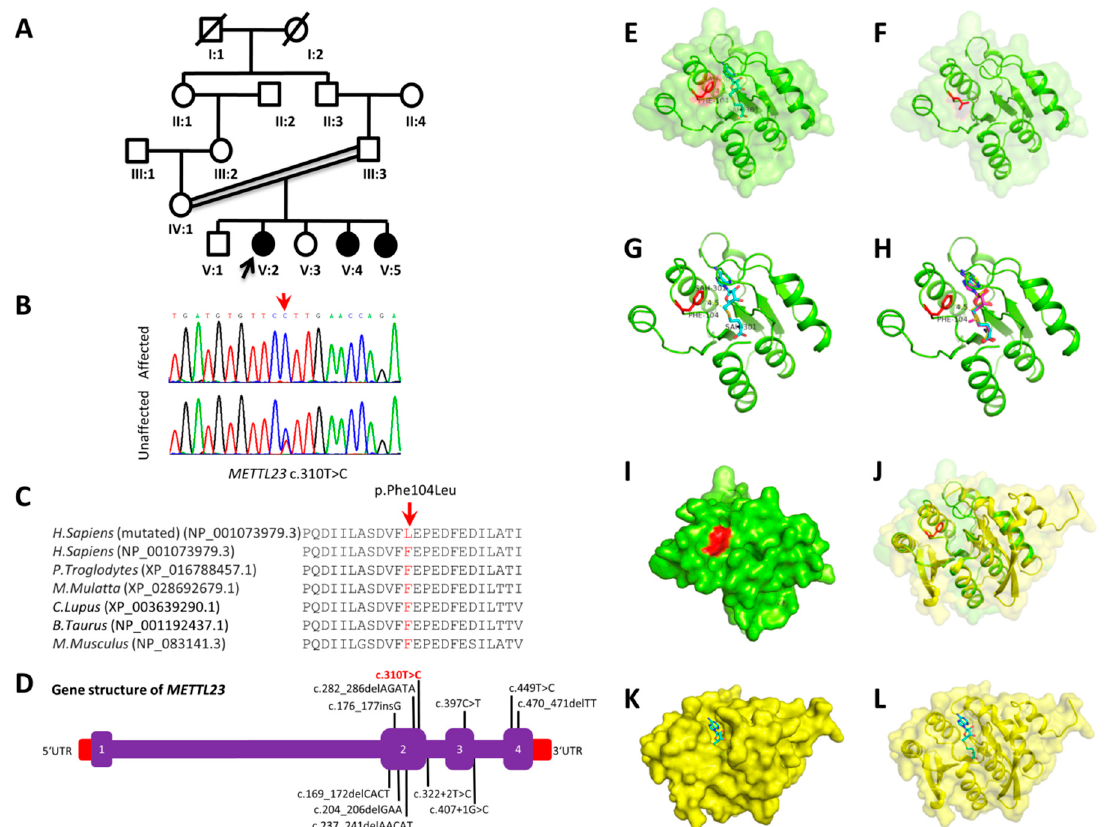
Figure 1. ( A ) Pedigree of family B, exhibiting autosomal recessive inheritance. ( B ) Sanger sequencing results of family (B). The red arrow indicates the localization of the variant. ( C ) Conservation of Phe104 across different species. ( D ) Gene structure of METTL23 . Known variants are indicated on the gene structure. The c.310T>C variant is shown in red. ( E ) The modeled structure in complex with the SAH ligand, which was superimposed according to the METTL21C structure. ( F ) The Phe104Leu mutation in the modeled structure. ( G ) Same as ( E ) without showing the molecular surface. ( H ) The superimposition of the SAH and SAM ligands from the METTL21A, METTL21B and METTL21C. ( I ) The molecular surface of the modeled structure of METTL23. ( J ) The superimposition between the modeled METTL23 and crystal structure of METTL21C. ( K ) The molecular surface of METTL21C. ( L ) The structure and molecular surface of METTL21C.